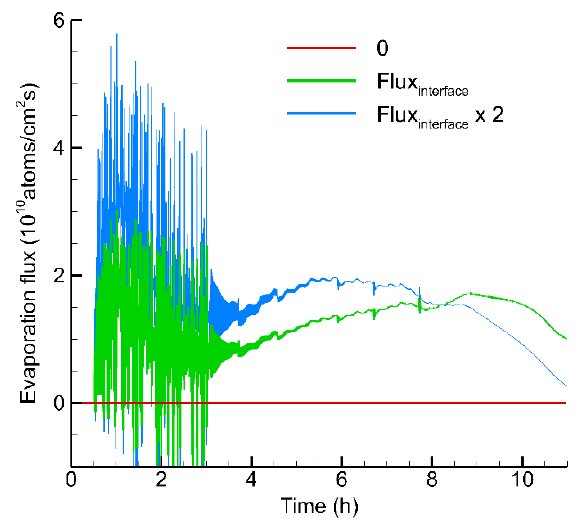
Figure 7. History of the phosphorus evaporation flux at the melt surface as a function of time. The phosphorus evaporation flux at the melt surface was (i) 0, (ii) the same as the phosphorus incorporation flux at the melt–crystal interface, and (iii) twice as large as that of case (ii).